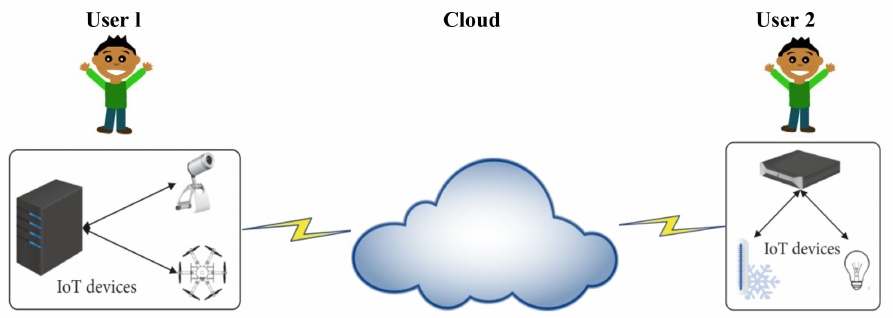
Figure 1. Cloud-Based IoT data